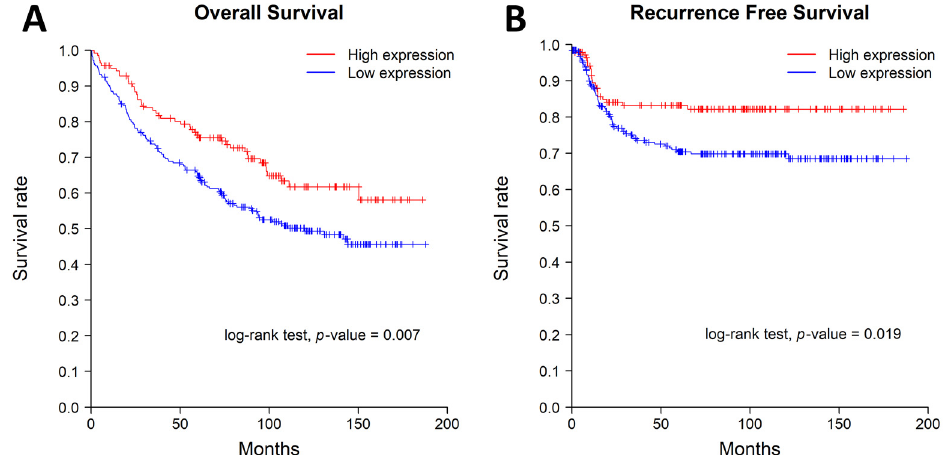
Figure 2. Kaplan–Meier curves for overall survival ( A ) and recurrence-free survival ( B ). The patients with low cytoplasmic MTUS1 protein expression showed worse overall survival ( p = 0.007) and recurrence-free survival ( p = 0.019). Table 3. Univariate and multivariate Cox regression analysis for overall survival in patients with colorectal adenocarcinoma ( n = 393).